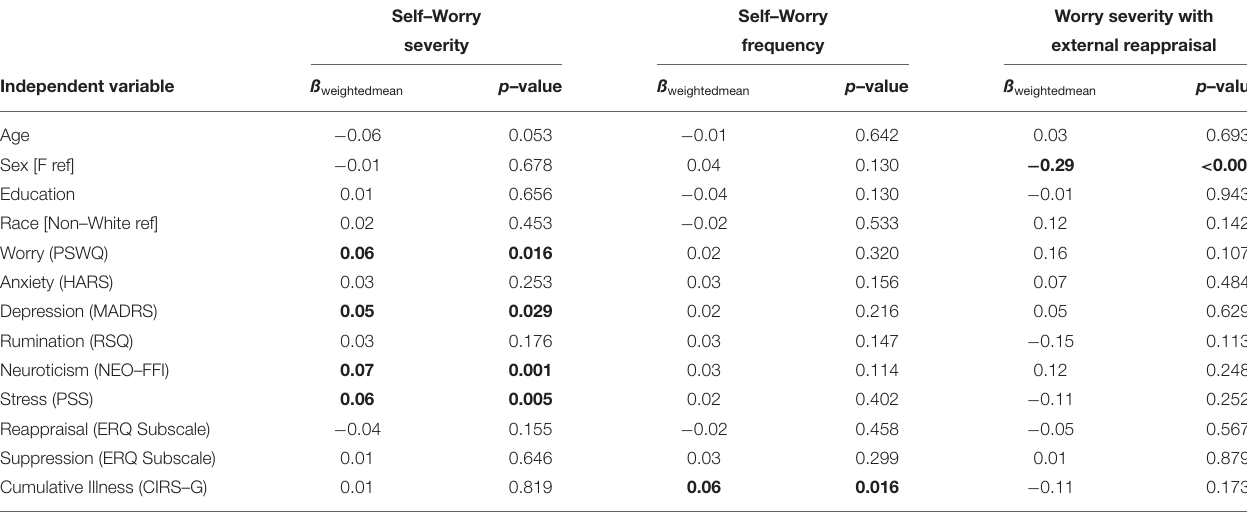
TABLE 2 | Significant predictors of self–worry severity, self–worry frequency, and worry severity with external reappraisal (only significant